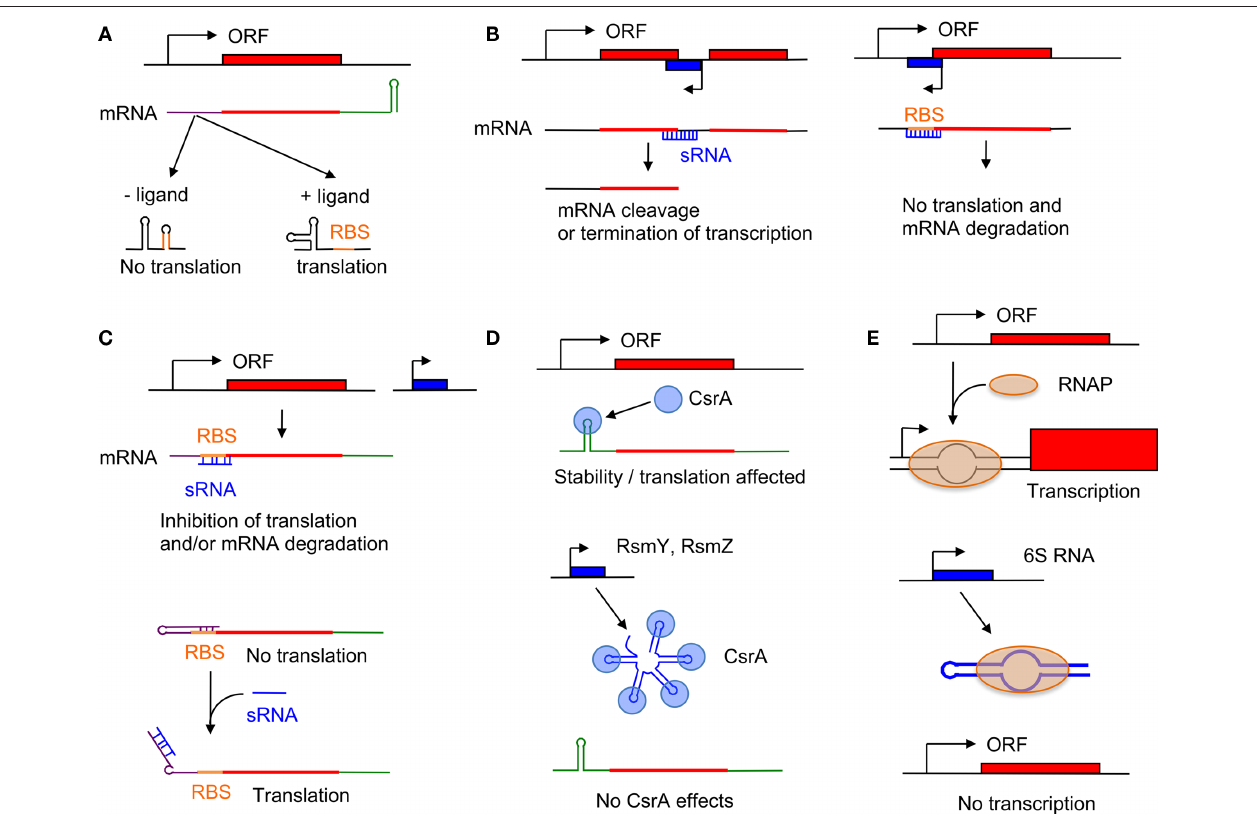
FIGuRe 1 | Mode of action of sRNAs. (A) Riboswitch; (B) cis-encoded base-pairing sRNA; (C) trans-encoded base-pairing sRNA; (D) CsrA system; (e) 6S RNA. See text